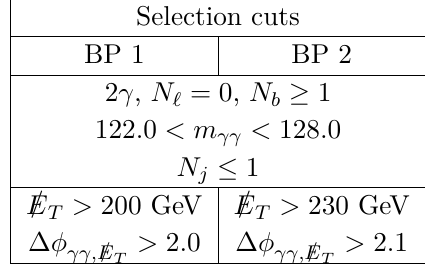
Table 23. The selection cuts optimised in the b-tag γγ + /E BPs